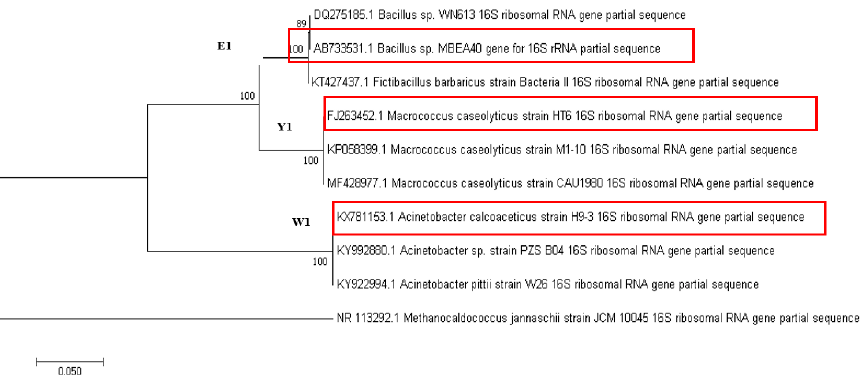
Figure 1. Phylogenetic tree of isolated strains from silicate ores, based on 16 rRNA sequencing analysis and using the MEGA7 software for generating the phylogenetic tree.